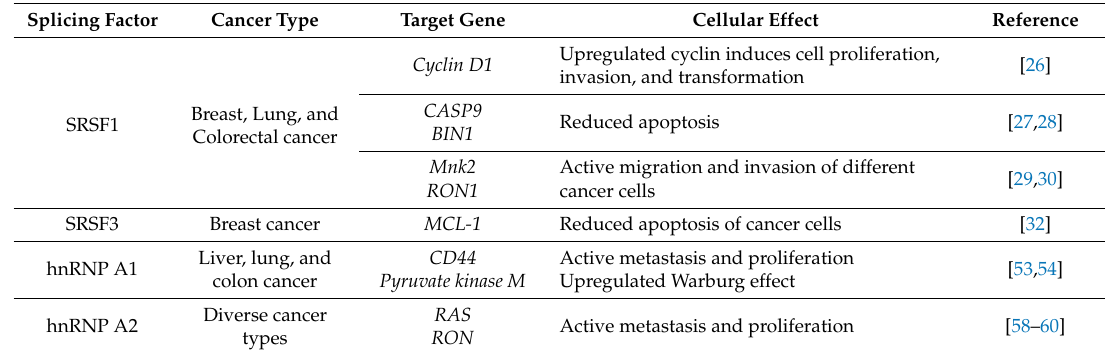
Table 1. The influences of splicing factors in cancer